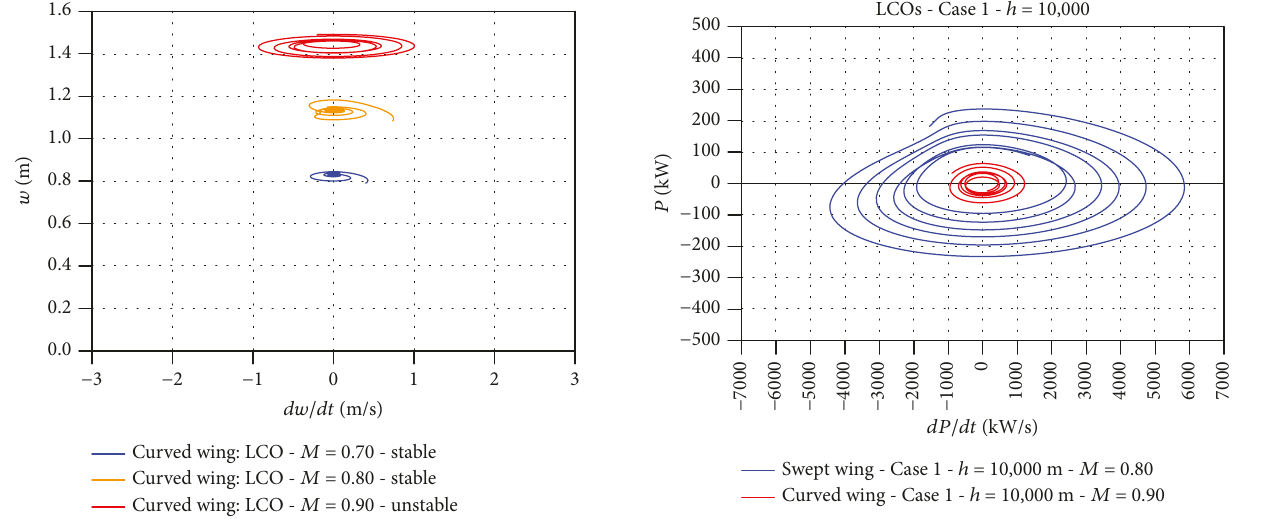
Figure 25: FSI DB — estimation of fl uid power LCOs (Case